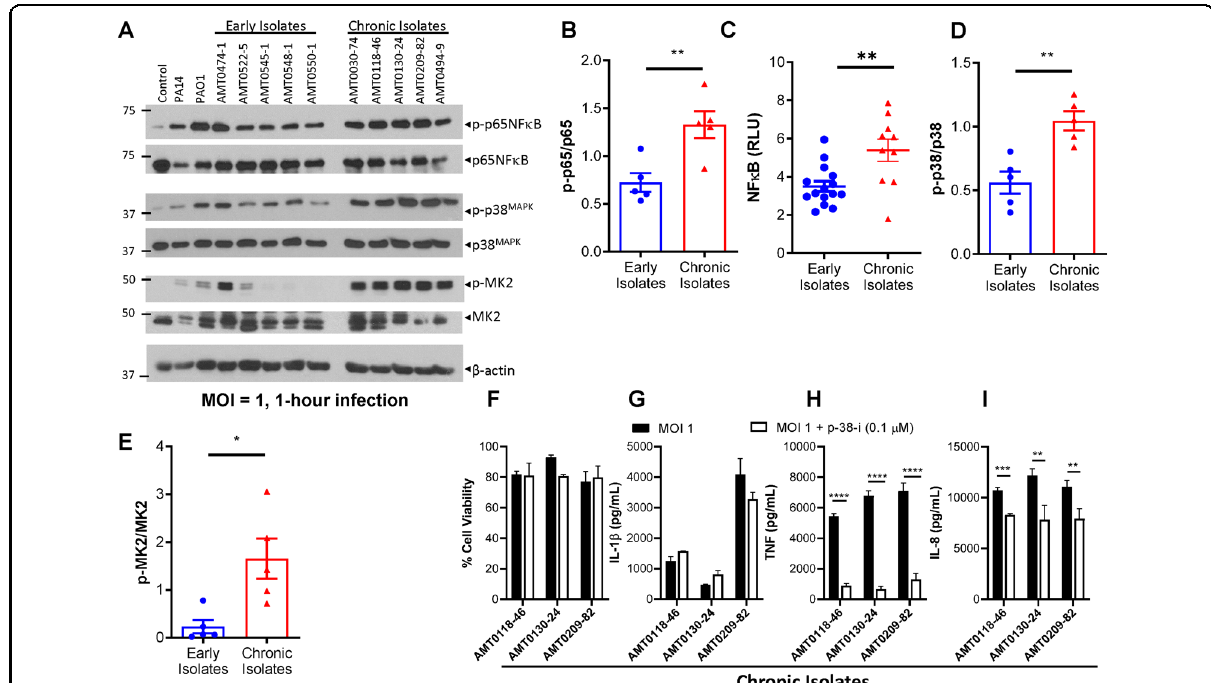
Fig. 4 Chronic CF infection P. aeruginosa isolates induce increased activation of NF- κ B and MAPK more than the early infection isolates. THP-1 macrophages were seeded at 500,000 cells/well in a 24-well plate. Immunoblotting was conducted on lysates collected at 1 h postinfection with the indicated CF P. aeruginosa isolates at 1 MOI ( A ). Densitometric analysis of western blots shown in panel A was performed ( B , D , E ). THP-1 Lucia ™ NF- κ B cells were differentiated and incubated with 1 MOI of heat-killed early or chronic CF P. aeruginosa isolates in experimental triplicates. At 3 h, supernatant luciferase activity (relative light units, RLUs) was measured to assess NF- κ B activation ( C ). THP-1 macrophages were seeded at 100,000 cells/well in a 96-well plate. Ralimetinib, a p38 MAPK inhibitor, was added during infections with select chronic P. aeruginosa isolates from CF patients to a fi nal concentration of 0.1 µM. Cell viability via neutral red assay ( F ) and cytokine production via ELISA ( G – I ) were then measured 3 h postinfection. Mean ± SD of triplicates of a representative experiment are shown. Mean values were compared by Student ’ s t -tests. (* P < 0.05, ** P < 0.01, *** P < 0.001, **** P <